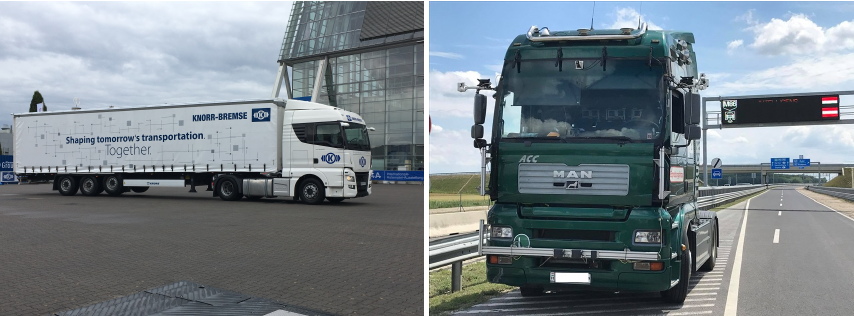
Figure 13. Knorr–Bremse tractor–semitrailer combination ( left ). Solo tractor test vehicle ( right